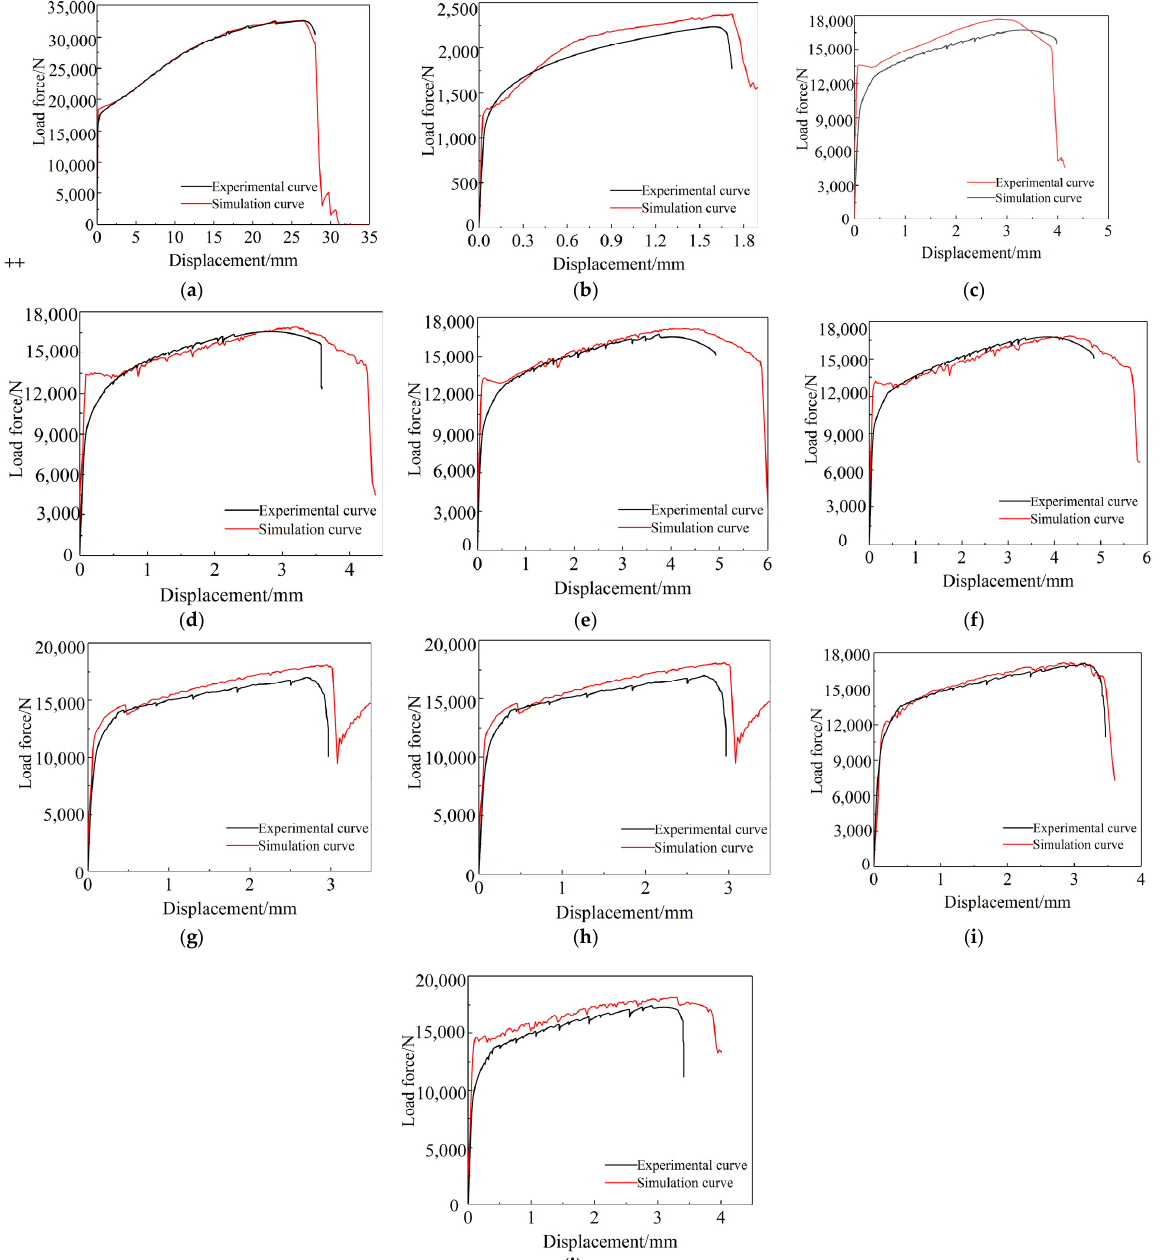
Figure 8. Comparison of experimental and numerical load force-displacement curves by Johnson–Cook failure model. ( a ) Circular arc tensile sample. ( b ) Shear sample. ( c ) R = 5 mm. ( d ) R = 6 mm. ( e ) R = 8 mm. ( f ) R = 11 mm. ( g ) R = 15 mm. ( h ) α = 60°. ( i ) α = 90°. ( j ) α = 120°.